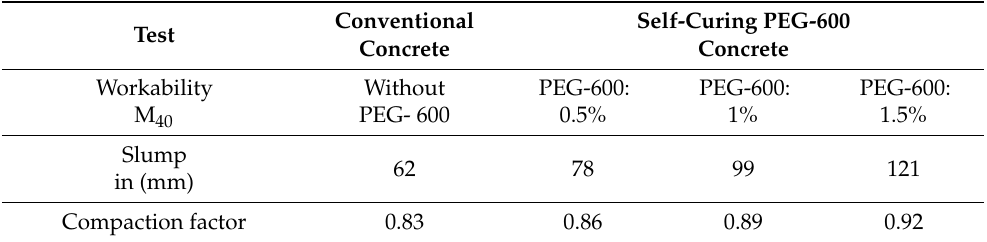
Table 7. Workability for conventional and polyethylene glycol (PEG-600) concretes.